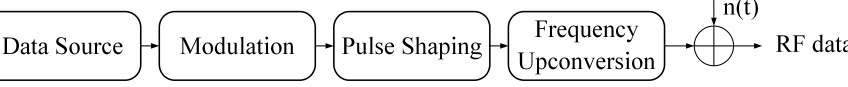
Figure 8. Single signal generation